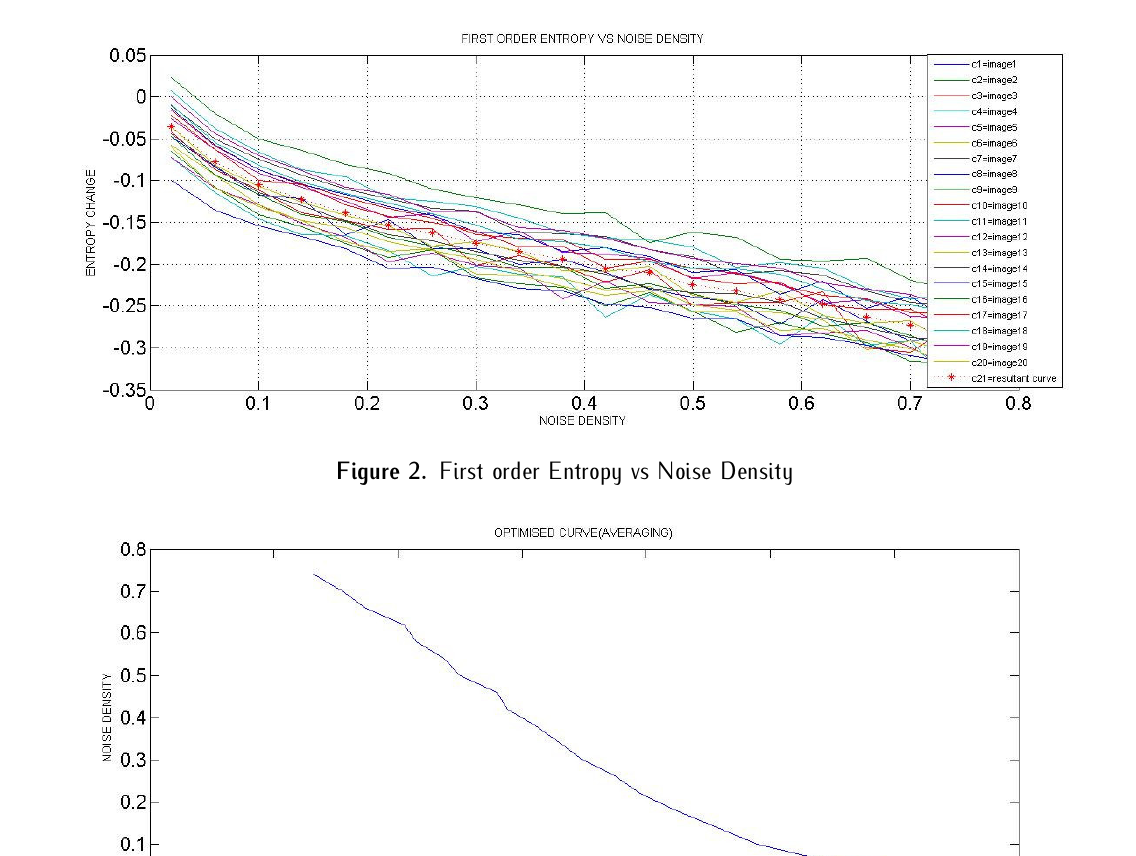
Figure 1. System Flow Diagram